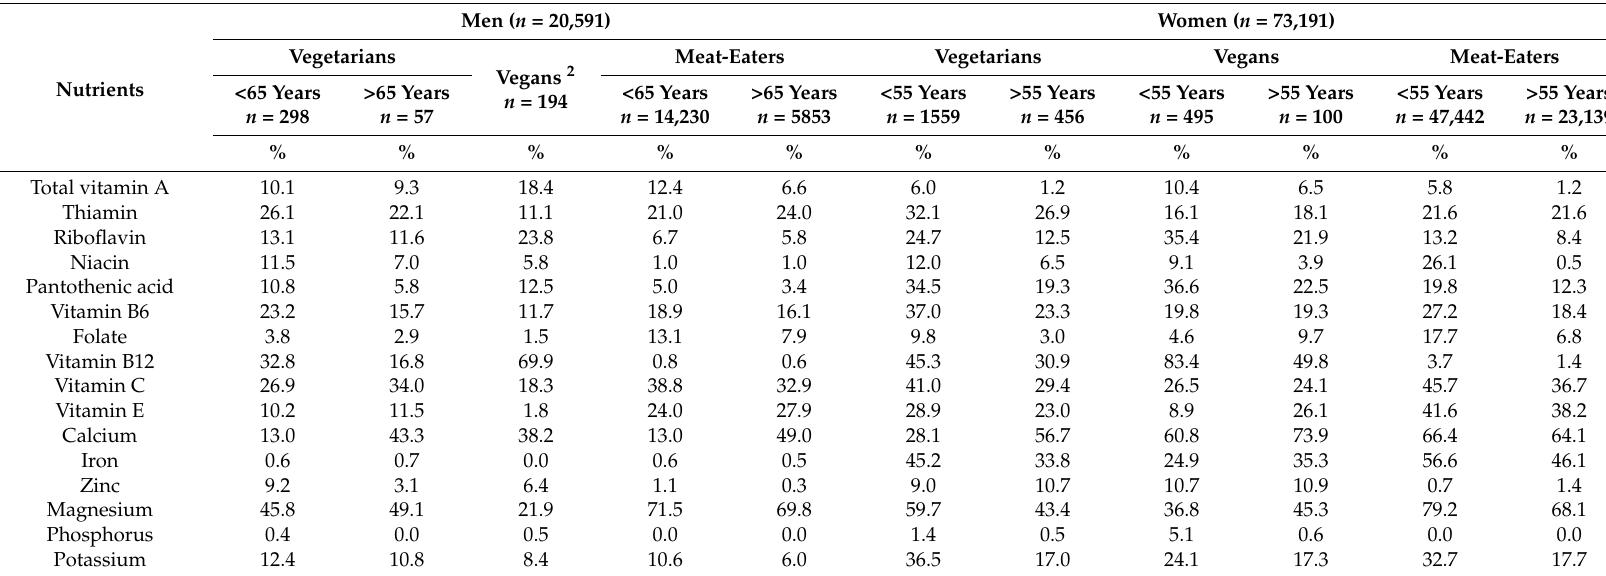
Table 7. Prevalence of dietary nutrient inadequacy 1 among vegetarians, vegans, and meat-eaters (Nutrinet-Sant é Study 2009–2015, n =